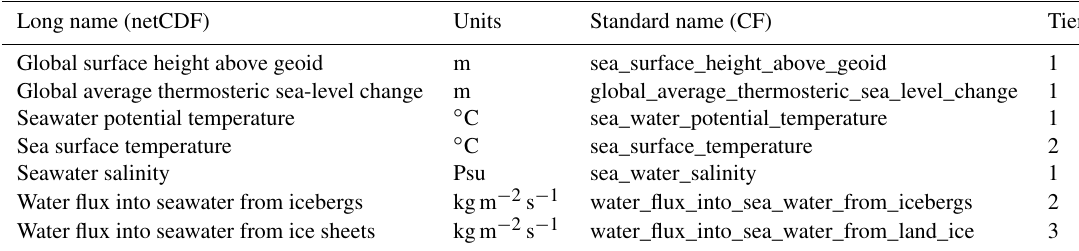
Table A2. Data on the Omon Tables (Monthly Mean Ocean Fields) needed to capture the glaciated/ice-sheet surface realm or for intercom- parison of the model simulations. These fields are saved on the ocean grid and contain monthly output. Data preparation should follow the CMIP6-Endorsed OMIP protocol. Tier indicates the priority of the variable: Mandatory (1), Desirable (2), Experimental (3). These vari- ables are requested for climate models participating in the diagnostic component of ISMIP6 (Table 1) and for the XXX-withism experiments (Table 2). Flux variables are defined as positive when the process adds mass to the ocean and as negative